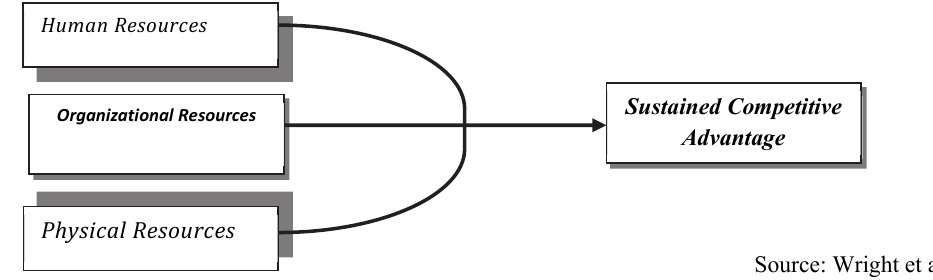
Fig. 1. Route to Sustained Competitive